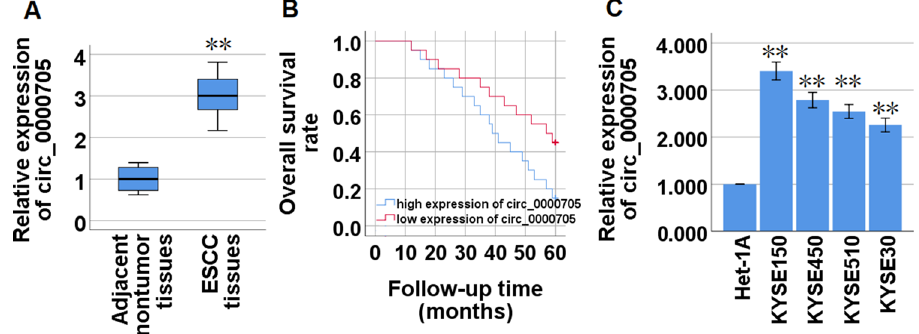
Fig. 1 Circ_0000705 expression in ESCC tissue specimens and cell lines. A The expression patterns of circ_0000705 in ESCC tissues com- pared with adjacent non-tumor tissues (n = 40). B Kaplan–Meier’s analysis of the correlation between circ_0000705 expression and the over- all survival rate (OSR) of ESCC patients. C The expression patterns of circ_0000705 in Het-1A and ESCC cell lines (KYSE150, KYSE450, KYSE510 and KYSE30) were detected by qRT-PCR. * P < 0.05, and ** P < 0.01 vs